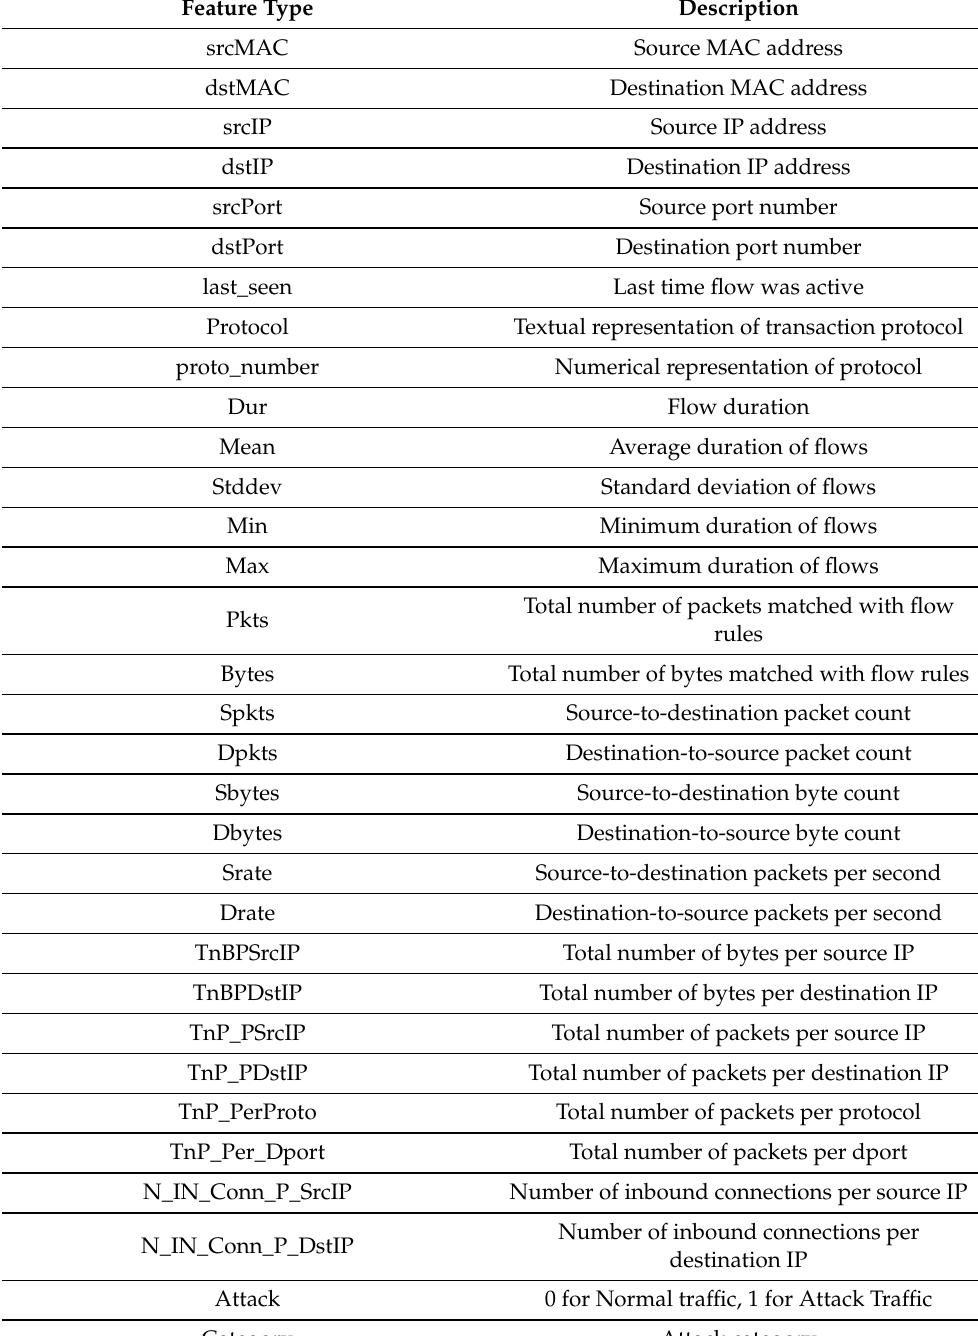
Table 2. Dataset features and their